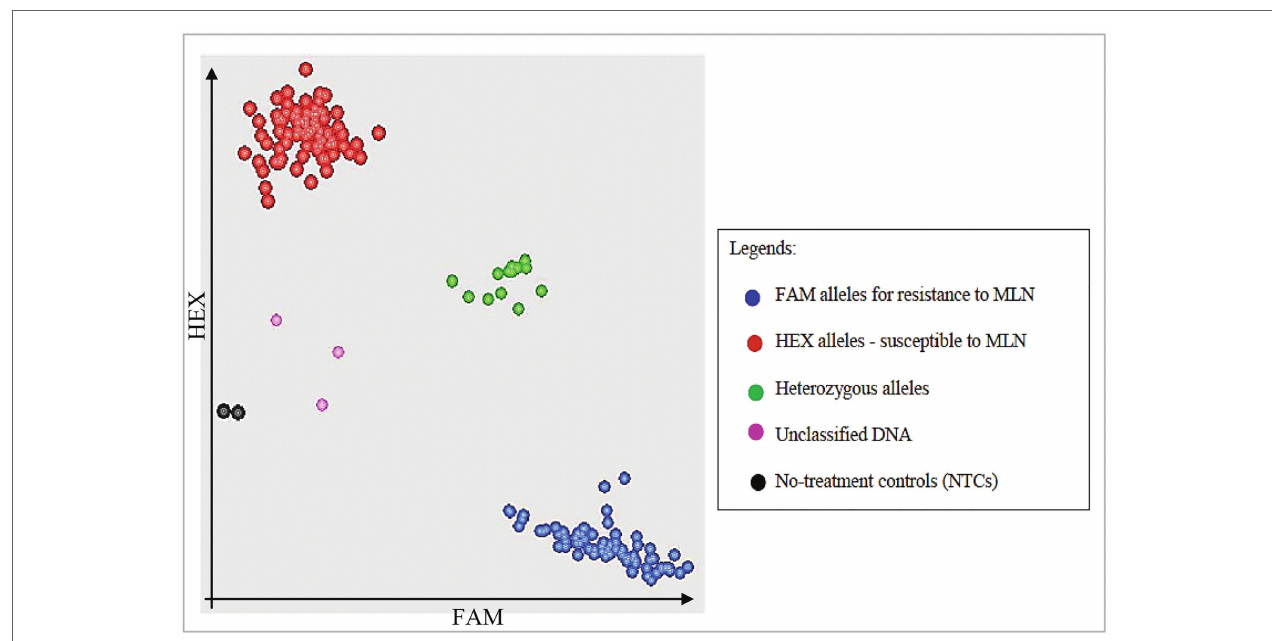
FIGURE 1 | Schematic illustration of kompetitive allele specific PCR (KASP) cluster plots showing segregation of bi-parental backcross (BC) populations for alleles for resistance and susceptibility to maize lethal necrosis (MLN). Fluorescein amide (FAM) alleles for resistance to MLN are clustered on x-axis, while susceptible Hexachloro-flourescein (HEX) alleles are on